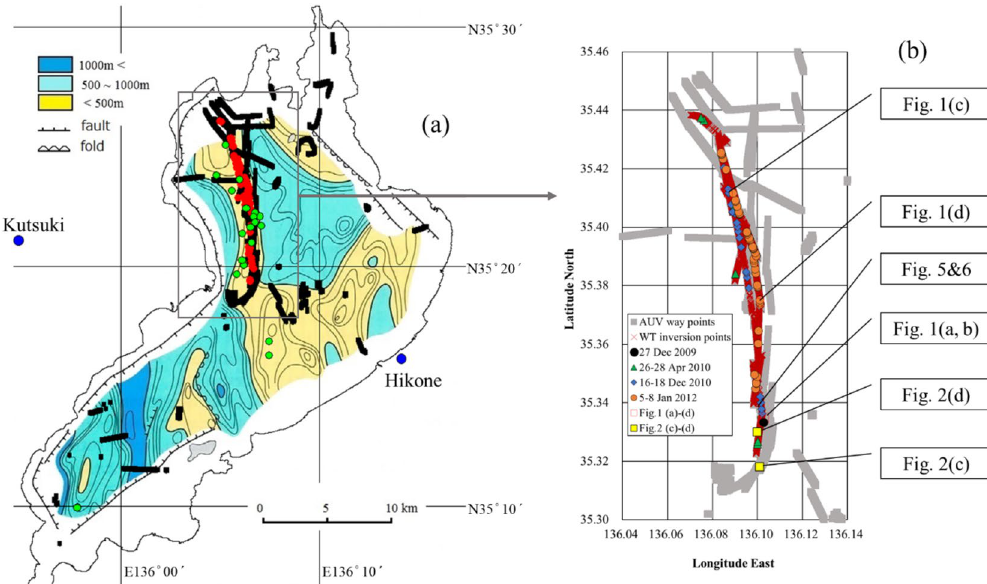
Figure 3. Waypoint locations for the AUV Tantan operated from 2001 to 2012 and the benthic vents detected from 2009 to 2012. ( a ) The way points (filled black rectangles) and the vents (orange circles) are plotted on the modified basement rock map of Lake Biwa with sediment thickness indicated with a color index (after Uemura and Taishi, 1990). The green circles indicate large ebullitions of gas and water observed using a quantitative echo sounder from 2012 to 2019. Noteworthy is that these vents are located along the shallow sedimentation region (< 500 m) indicated by light yellow, which may correspond to an ancient mountain range of several (grey rectangle), water temperature inversion points measured by Tantan (red crosses) and vents from 2009 to 2012 (measurement dates are given in legend). A sediment temperature profile in Fig. 4 was measured at